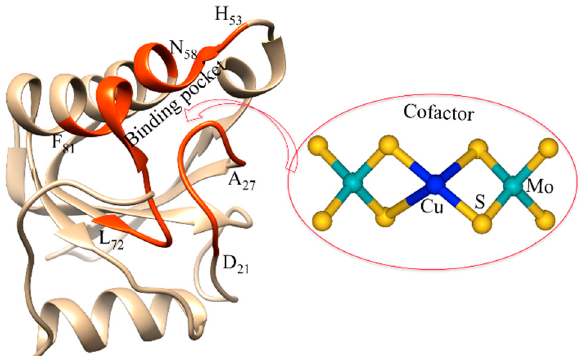
Figure 5. Crystal structure of apo-ATCUN-ORP (PDB: 2WFB) where metal-cofactor [S 2 MoS 2 CuS 2 MoS 2 ] 3 − (EXAFS structure) binding region amino acid residues are highlighted with red color in